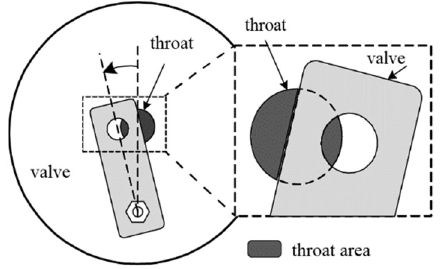
Figure 2. Schematic diagram of the servo valve.